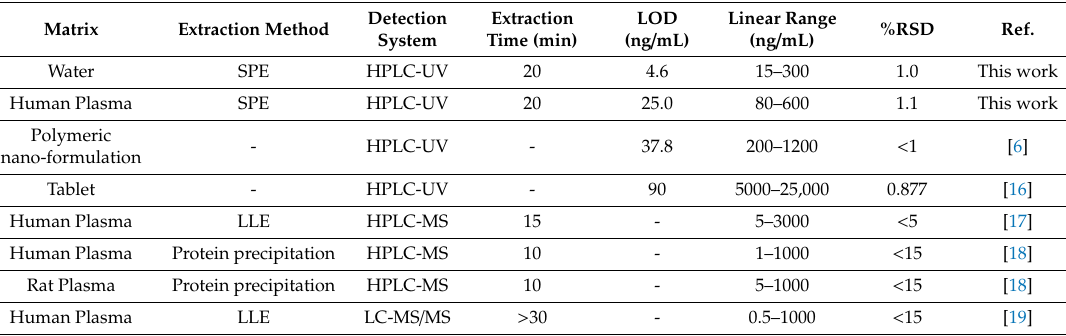
Table 1. Comparison of the proposed method with other reported methods to determine Gefitinib (GEF) in di ff erent sample